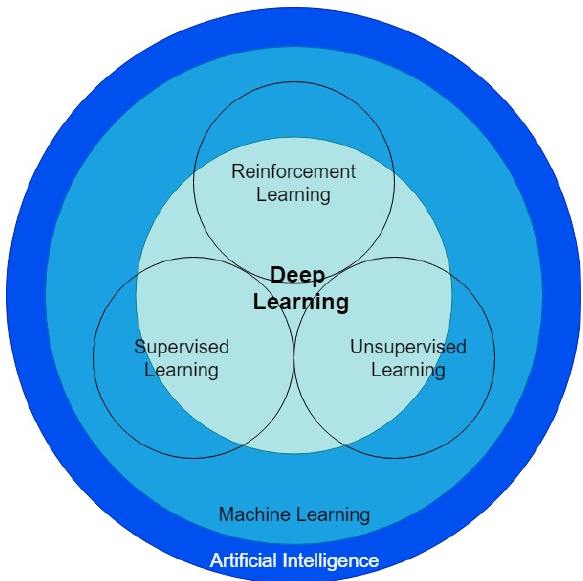
Figure 1. The classification of artificial intelligence related technologies.